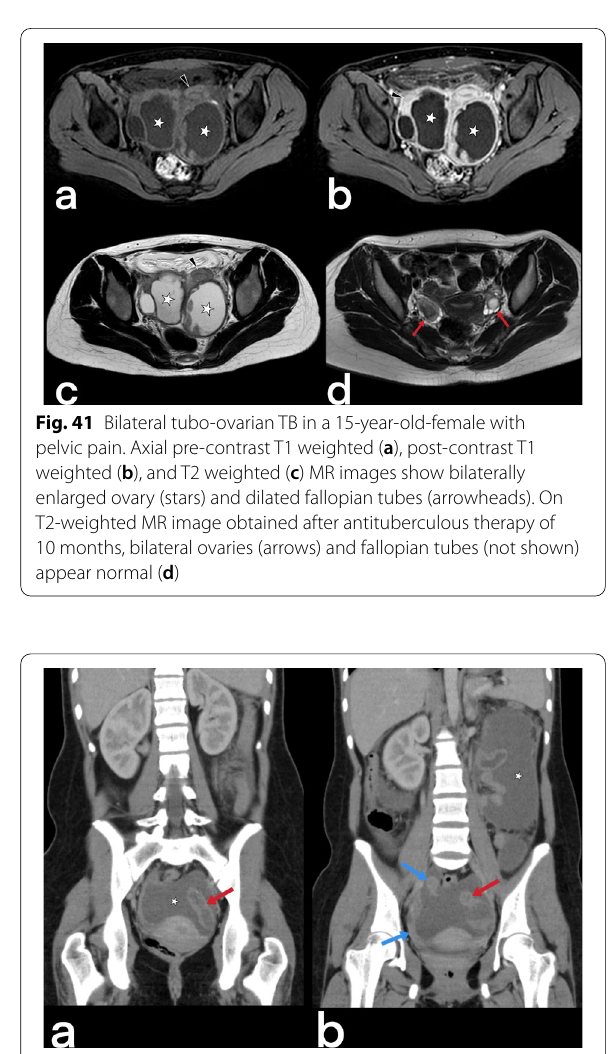
Fig. 42 Bilaterally hydrosalpinx (right: blue arrows, left: red arrow) and ascites (stars) in the peritoneal cavity are observed on coronal contrast-enhancement CT images ( a, b ) of the same patient (in Fig.